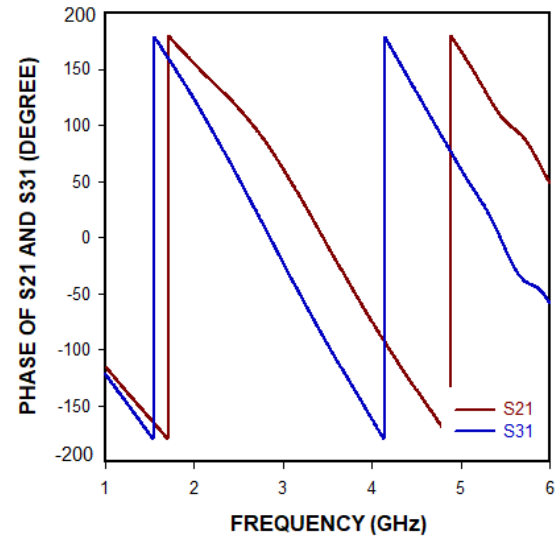
Fig.3. Conventional patch coupler frequency response